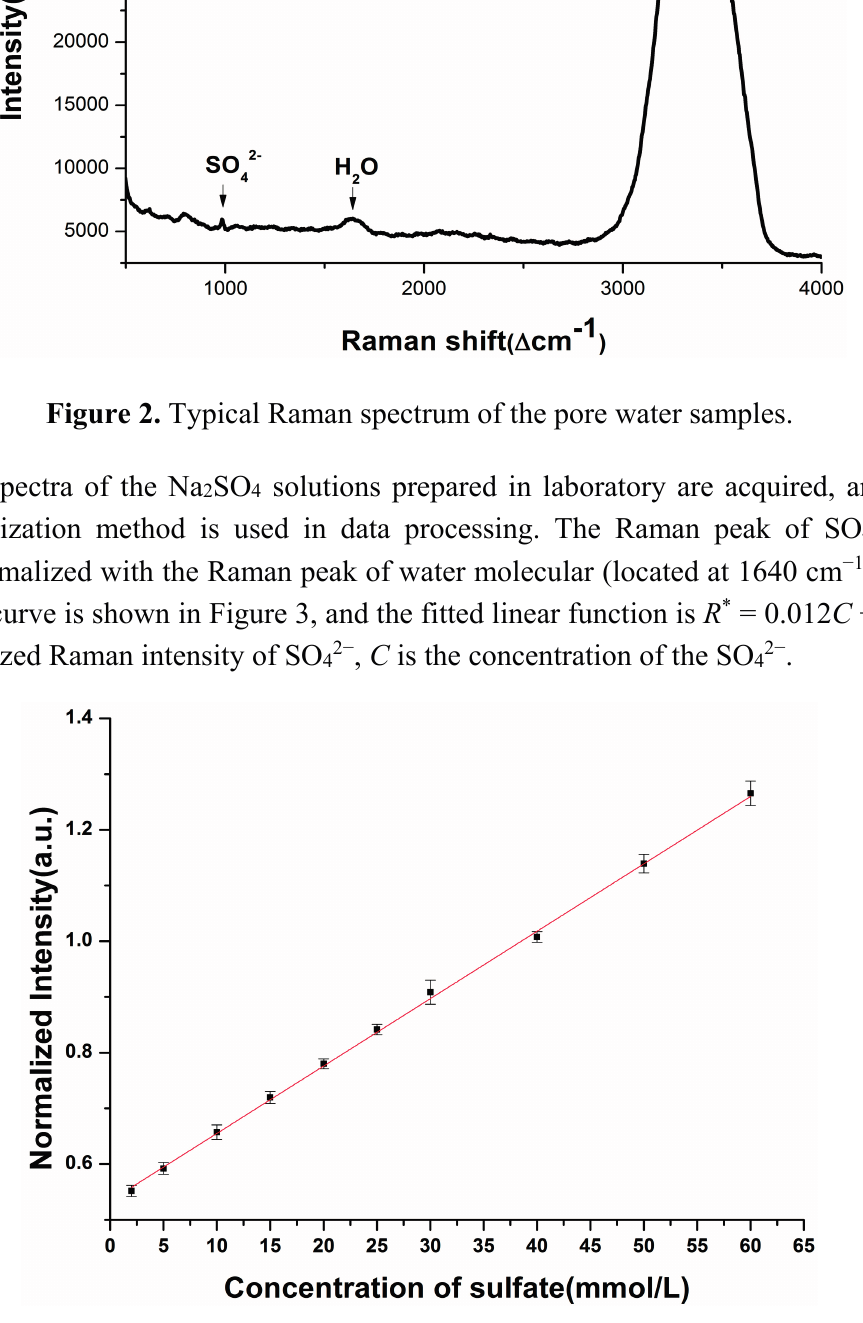
Figure 3. The calibration curve of sulfate concentration with conventional Raman